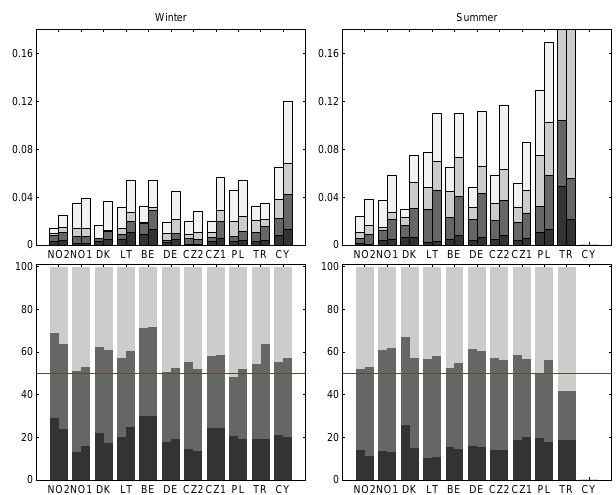
Figure 3. In the top row, total variance decomposed in variance from GCMs, RCMs, SDMs, and all the interaction terms (darkest to lighter grey colours). In the bottom row, percentage of the total variance explained by GCMs, RCMs, and SDMs (darkest to lighter grey colours). All the results are shown for 1- and 5-year levels in the left and right column of each catchment, respectively. All the results are for a temporal aggregation of 1